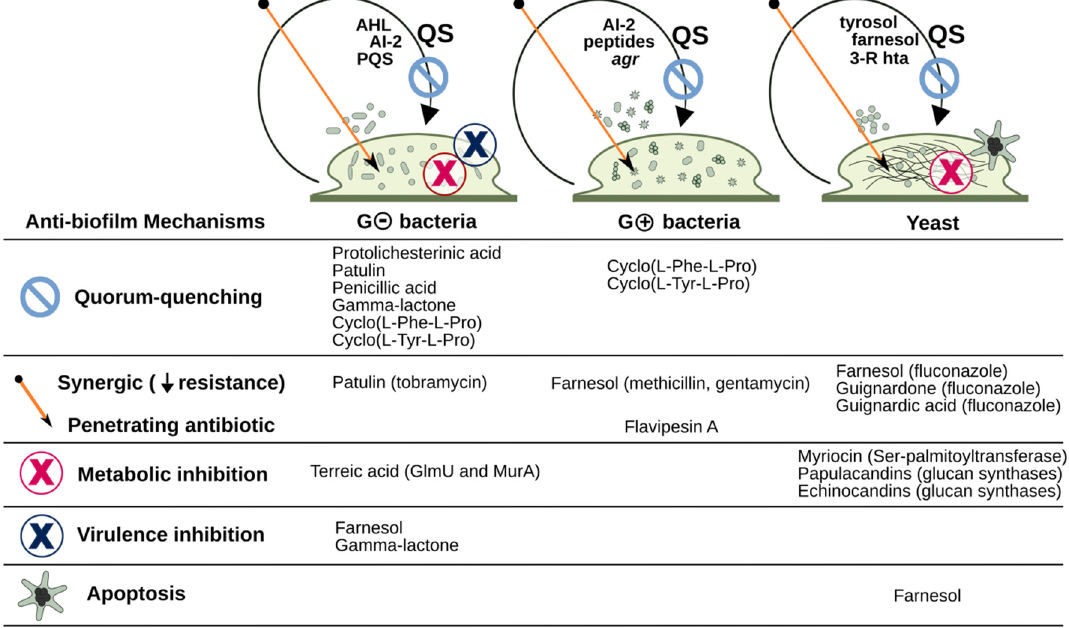
Figure 9. Anti-biofilm mechanisms of fungal molecules against Gram positive bacteria, Gram negative bacteria and yeasts, with examples of active compounds. QS: quorum sensing; AHL: acyl homoserine lactone; AI-2: auto-inducer-2; agr: accessory gene regulator system; PQS: Pseudomonas quinolone signal; 3R hta: 3R-hydroxy-tetradecanoic acid.